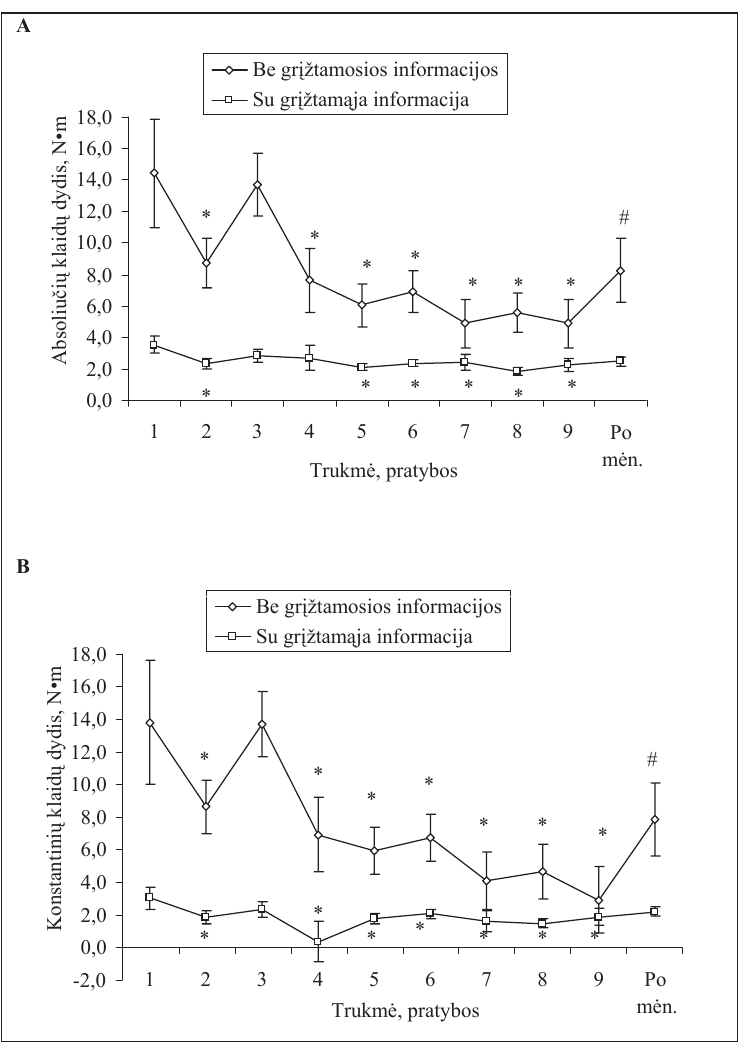
korekcija. Skirtumas statistiškai reikšmingas, kai p < 0,05. Skai č iavimai atlikti naudojant Microsoft ® Of fi ce Ecxel 2003 ir SPSS13 for Windows pro-